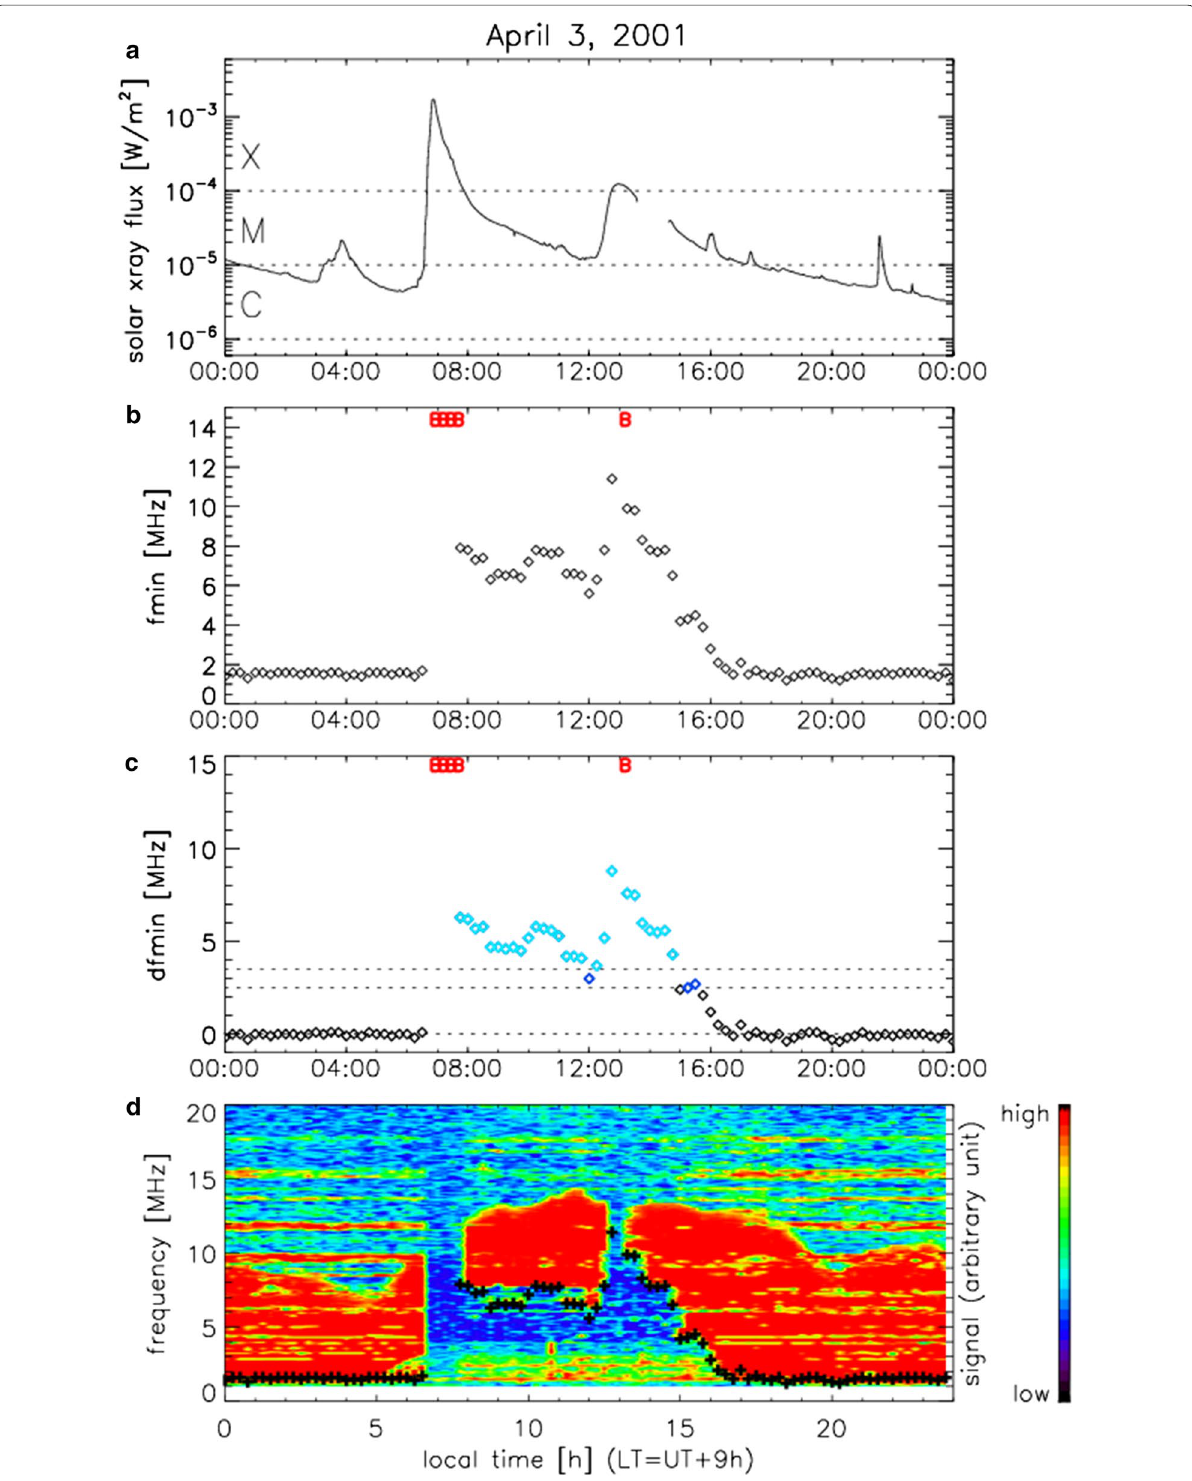
Fig. 5 Time variations in a solar X-ray flux, b f min, c d f min, and d maximum ionosonde signal at each frequency during the longest SWF event on April 3, 2001, observed at Kokubunji. The f min and d f min values of the blackout period are shown as “B” in red in b and c. d f min d f min 3.5 MHz values are shown in blue and light blue, respectively, in c. Black pluses in d show f min values. This event was recorded by the ≥ ionosonde system with an intensity resolution of 1 bit. The smoothing procedure in the analysis provides an arbitrary color scale with increasing signal intensity from blue to